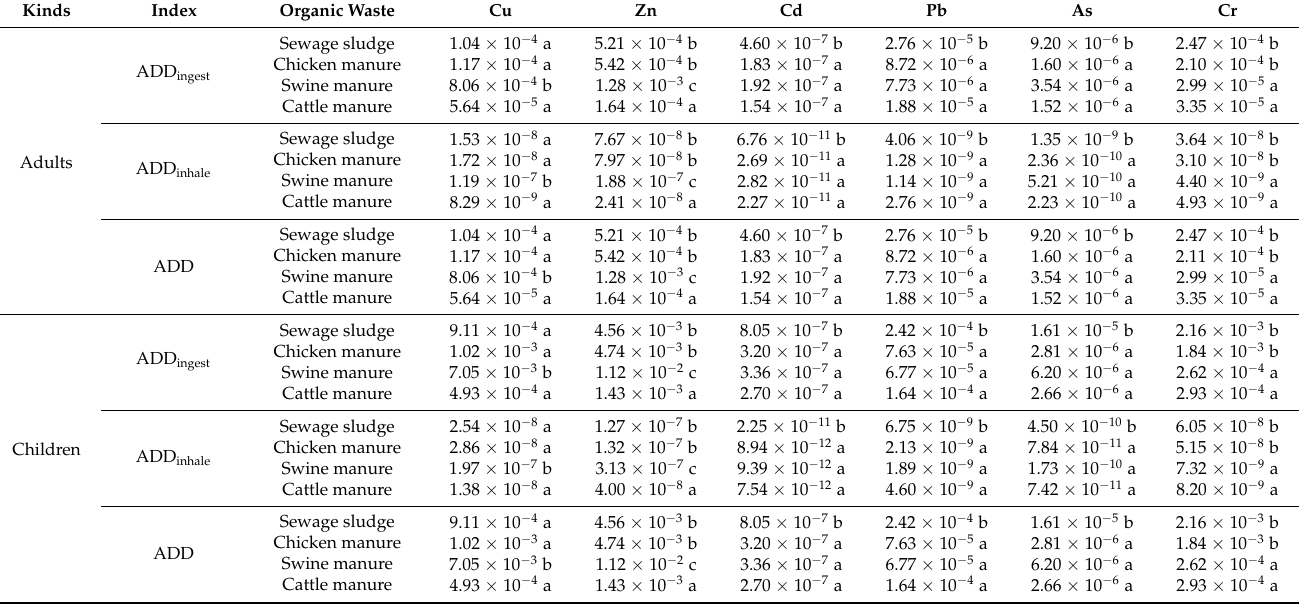
Table 5. Average daily dose (ADD) of heavy metals in sewage sludge and livestock manure (mg · kg − 1 · day − 1 ).